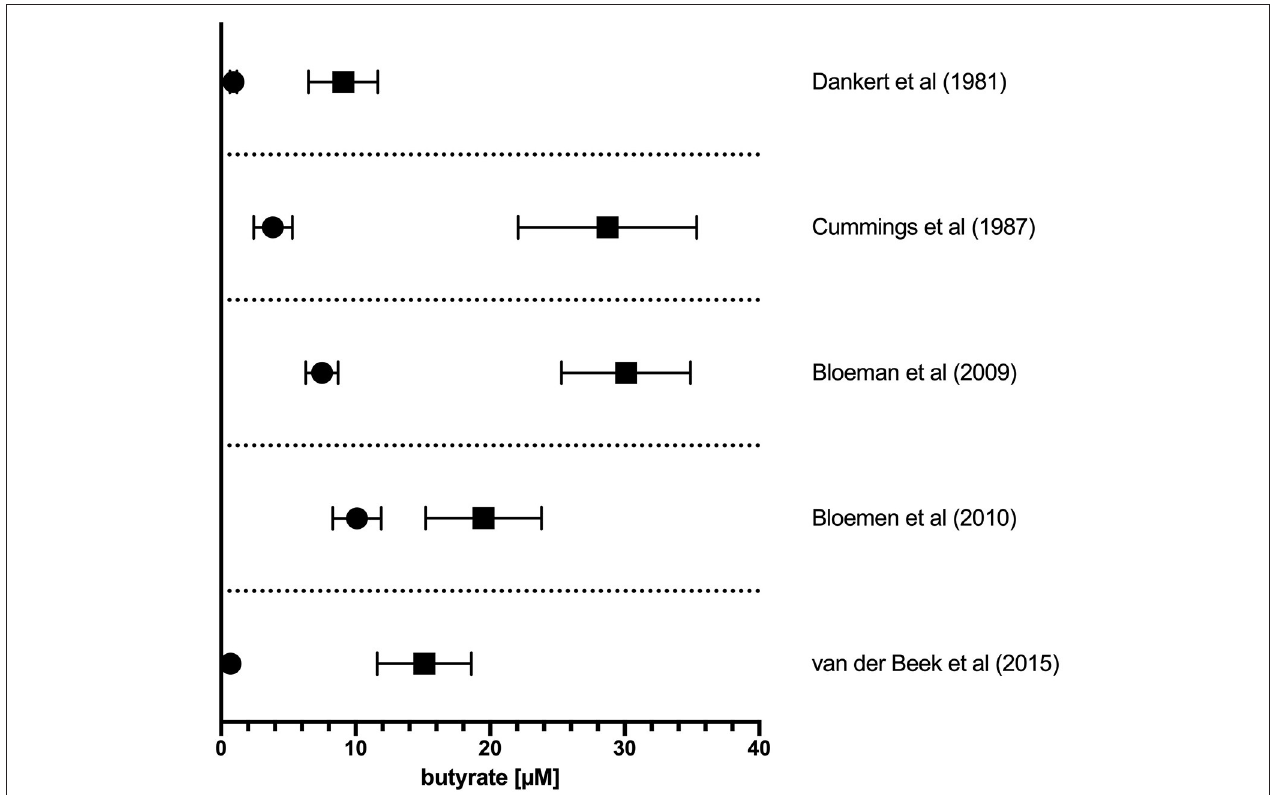
FIGURE 1 | Concentration of butyrate in portal vein and peripheral circulation in humans. The reported concentration of butyrate in plasma sampled from the portal vein plasma (solid squares) or peripheral circulation (solid circles). Values from original references were plotted and are displayed as means ± SEM as reported in original